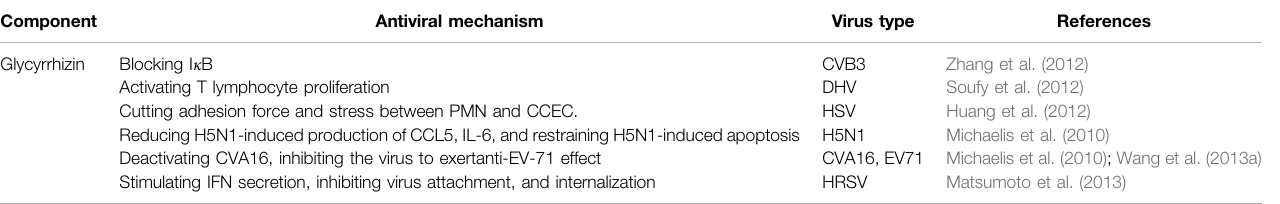
TABLE 2 | Antiviral active components and their possible mechanism of virus